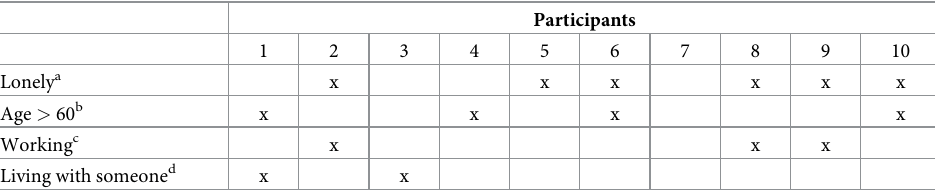
Table 1. Participant demographic